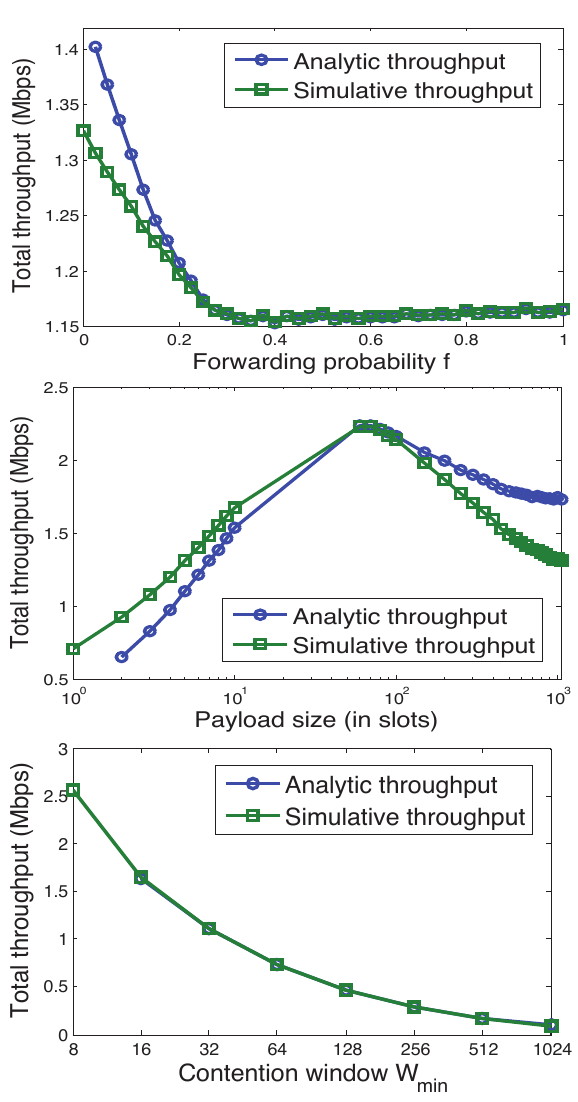
Figure 14. Average cycle size from model versus simulation under different parameters